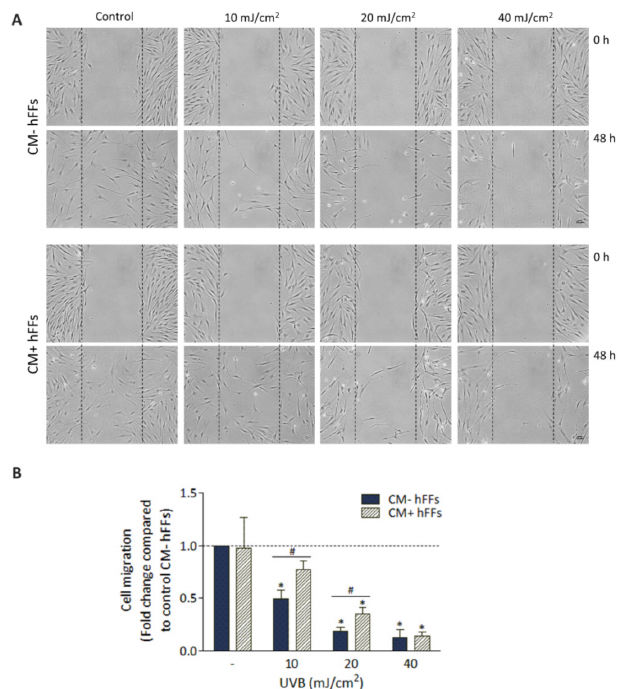
Figure 7. Effect of HC016-CM on wound closure. ( A ) Representative photomicrographs of wounded hFFs and cell migration at 0 and 48 h after irradiation. The dashed lines indicate the wound edges (scale bar: 50 µ m). ( B ) Quantitative data on cell migration 48 h after UVB exposure: fold difference in cell count. Results were normalized to controls (non-irradiated cells, dotted line). Data are expressed as mean ± SD. # p < 0.01. * p <